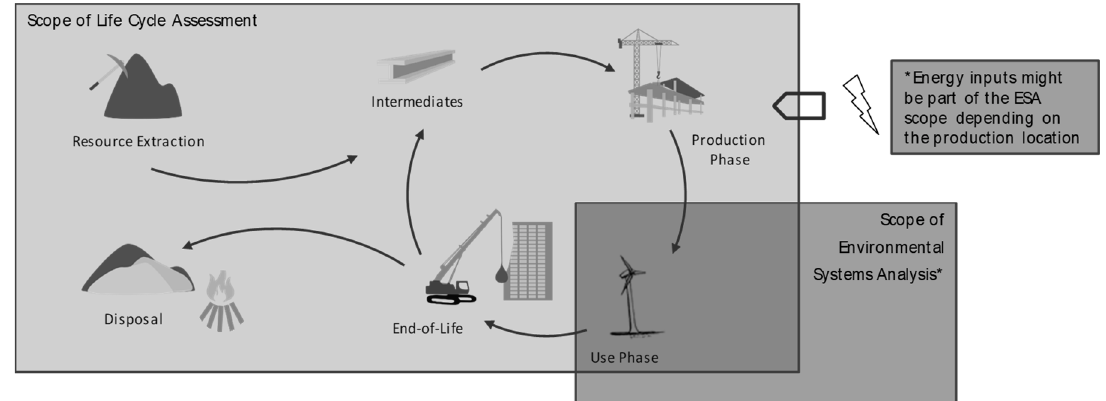
Figure 1. Graphical representation of the difference in the system boundaries for Life Cycle Assessment (LCA) and Energy Systems Analysis (ESA). LCA includes the environmental impacts from the whole life cycle, while ESA focuses on direct emissions from the use phase of, in this case an energy technology (energy inputs to other life cycle phases might be included depending on the production location).